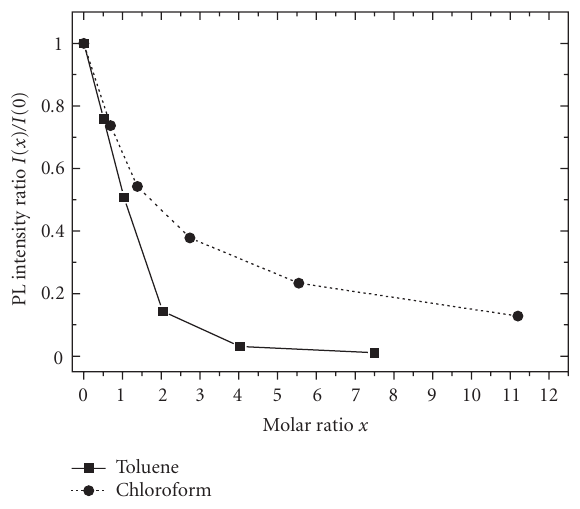
Figure 4: PL quenching of YQD by (m − Pyr) 4 H 2 P in toluene and